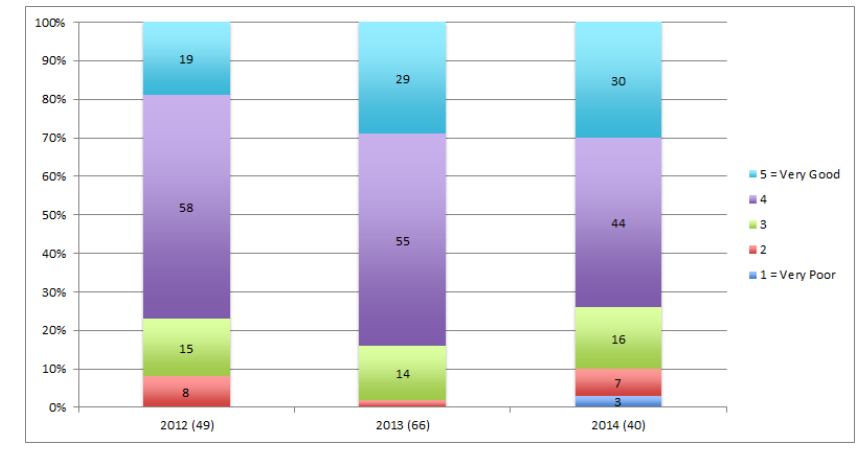
Figure 10. Judgement of academic/learning outcomes of the program